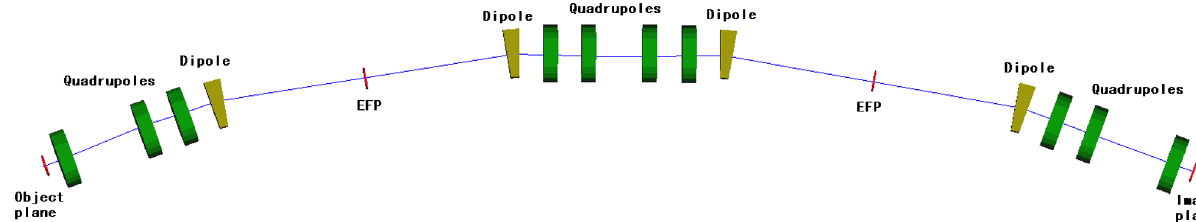
FIG. 3. G4beamline model of an energy-loss imaging lens